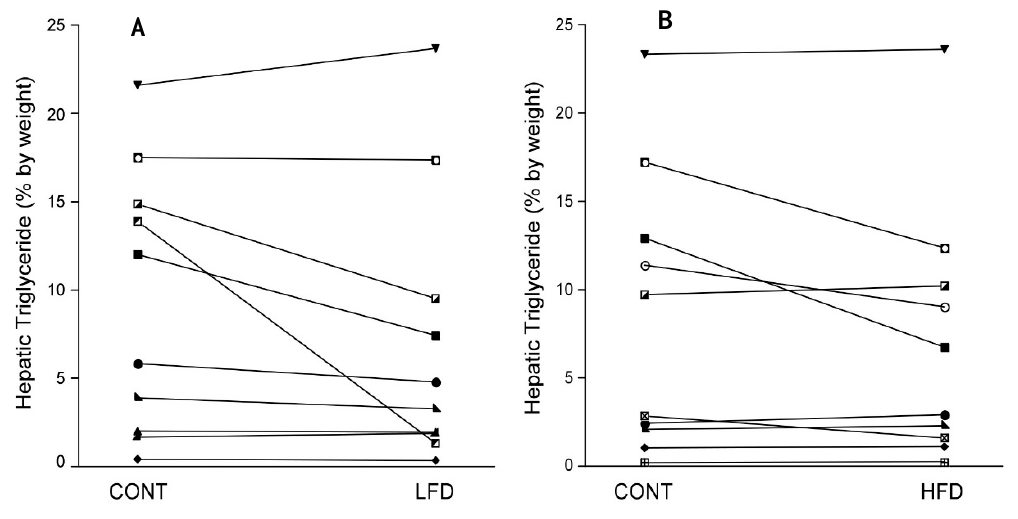
Figure 2. Effect of dietary fat on hepatic triglyceride. Compared to the CONT diet, hepatic triglyceride content by MRS decreased on the LFD (Panel A : mean (95% CI): change −2.13% (−3.74%, −0.52%)), but did not change on the HFD (Panel B ). One subject on the LFD had a dramatic decrease in hepatic triglyceride from 13.9% to 1.3%. Removal of this subject decreased the mean change, but there was still a significant decrease from the CONT diet (Panel A : change −1.18% (−2.11%, −0.25%)). A